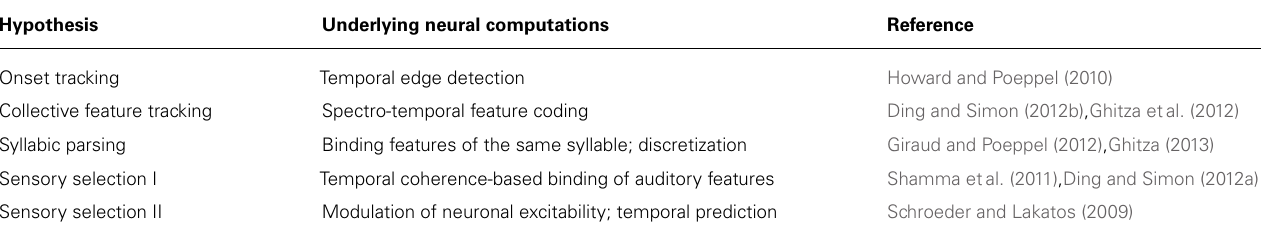
Table 1 |A summary of major hypotheses about the functional roles of cortical entrainment to